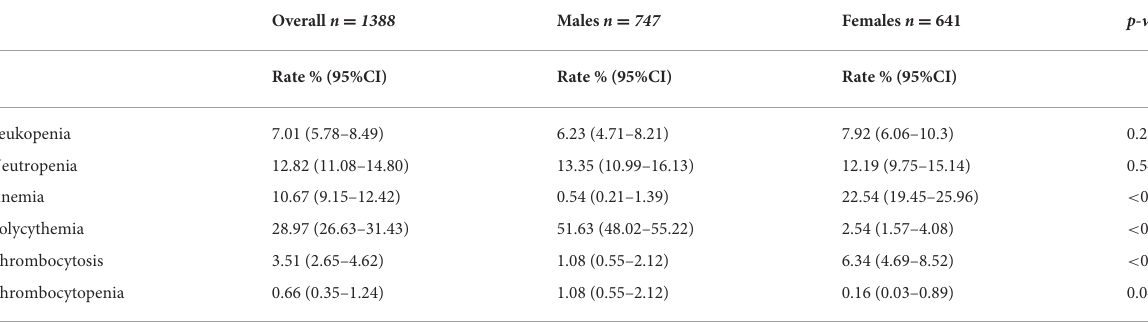
TABLE 4 Prevalence rate of leukopenia, neutropenia, anemia, polycythemia, thrombocytosis, and thrombocytopenia by gender.